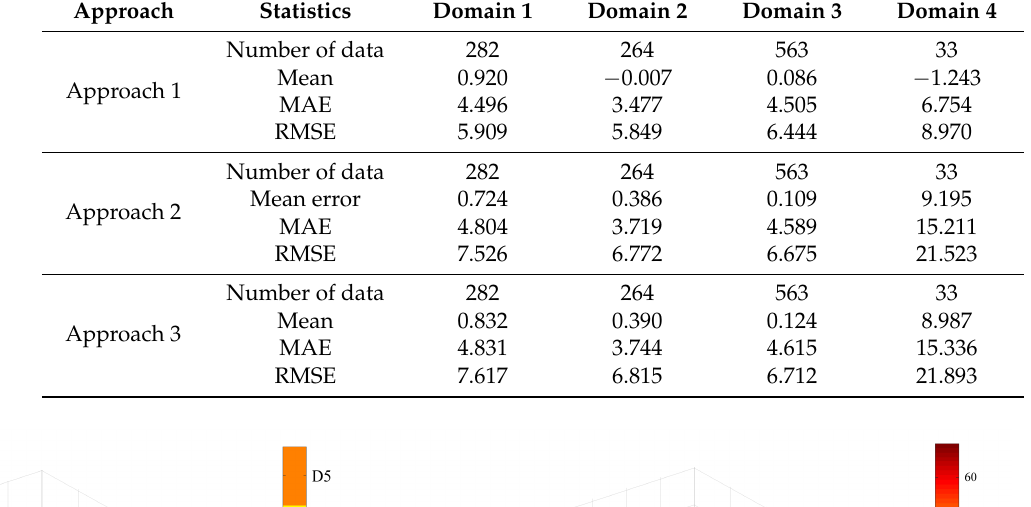
Table 6. Cross-validation scores for the estimation errors in D1 to D4 (subset of data distant no more than 6 m to a geological boundary).